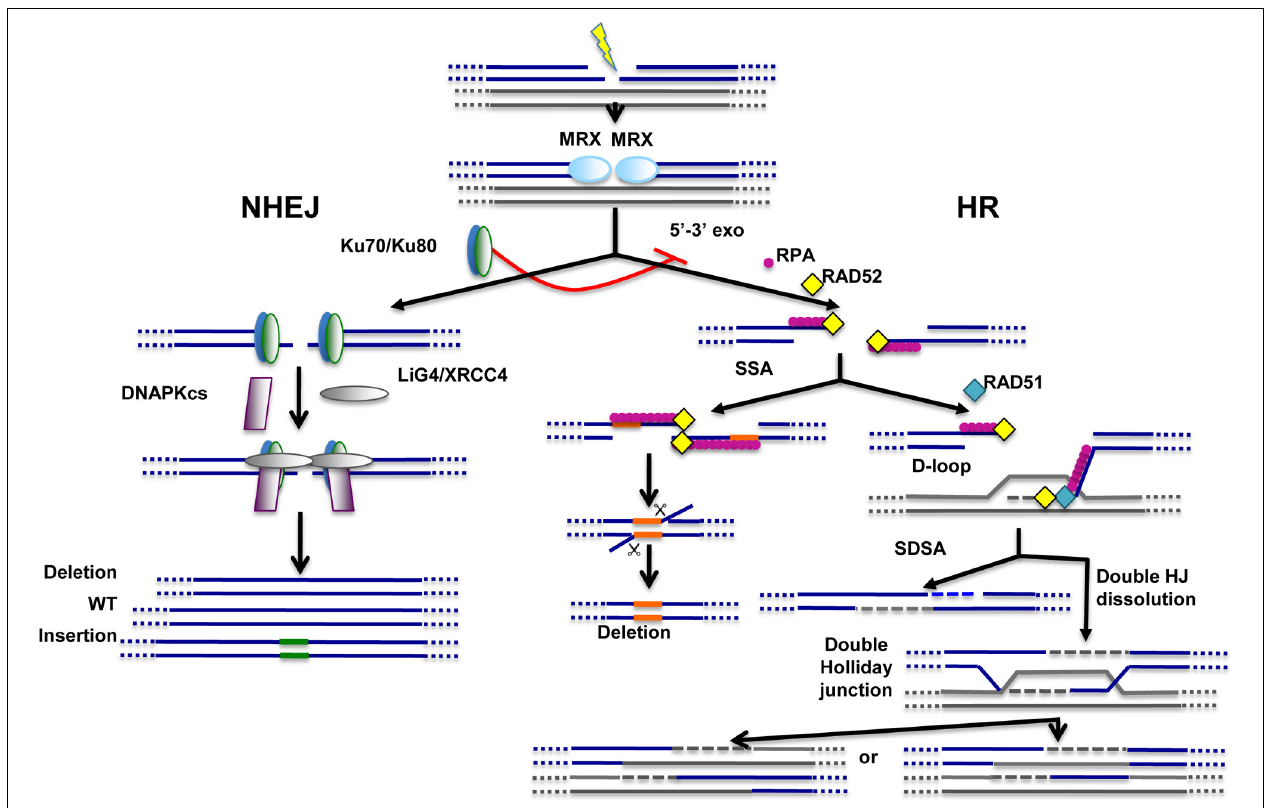
FIGURE 1 | Main pathways of DNA repair. Non-homologous end-joining (NHEJ) and homologous recombination (HR) pathways act competitively to repair DNA double-strand breaks (DSBs). Key players of NHEJ and HR are depicted.The MRE11/RAD50/XRS2 (MRX) complex is recruited very early at DNA ends and appears to play important roles for both NHEJ and HR. Ku70/Ku80 heterodimer is required for NHEJ and, through inhibition of DNA end resection (5 (cid:2) –3 (cid:2) exo), acts as a repressor of HR. Fidelity of NHEJ-dependent DSB repair is low and, most of the time, associated with nucleotide deletions and/or insertions at repair junctions.The common early